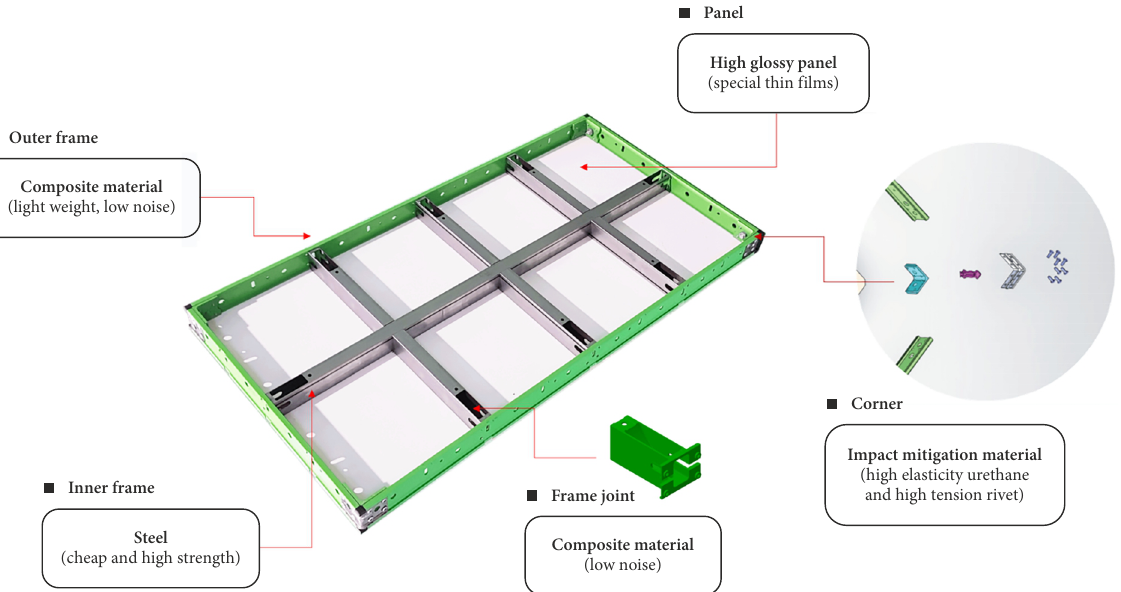
Figure 6. Idea combination for the CSF from the TRIZ inventive theory